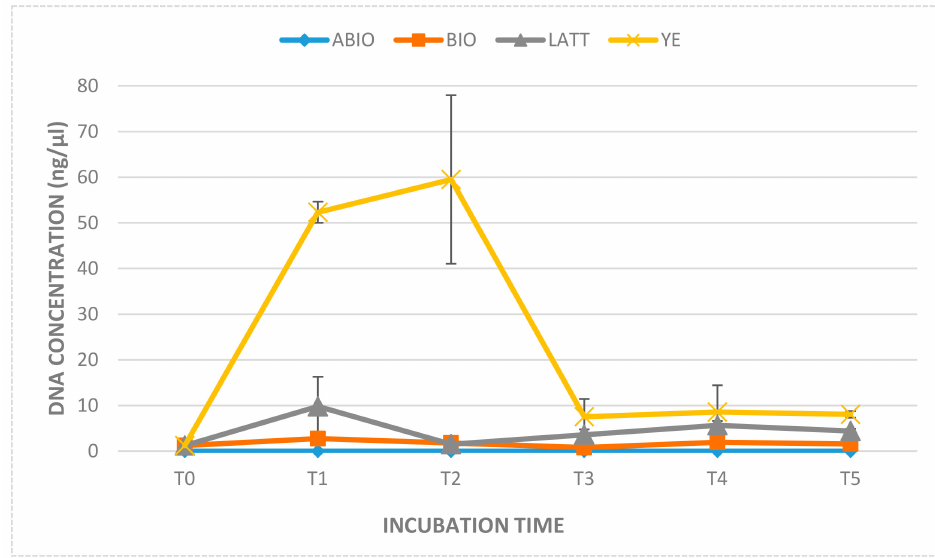
Figure 5. Concentration of genomic DNA extracted from the aqueous phase of each microcosms at di ff erent times of investigation (T1, T2, T3, T4, and